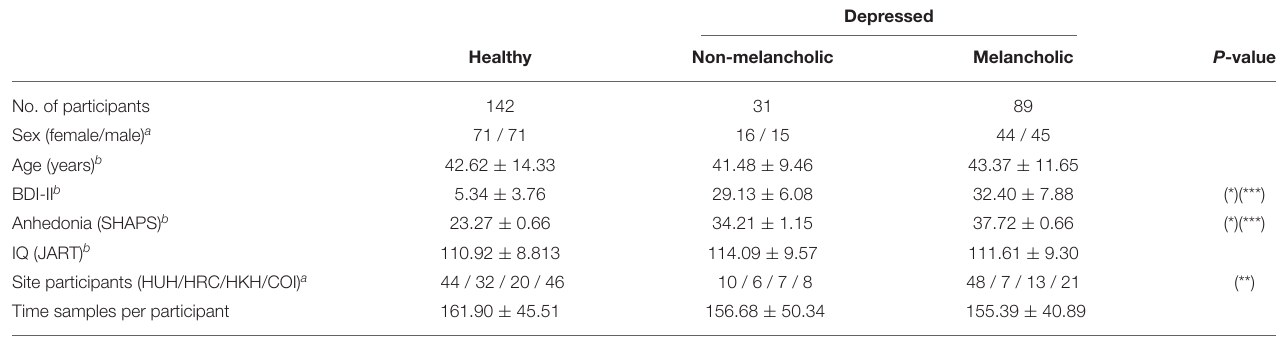
TABLE 1 | Demographic data of healthy and depressed participants.